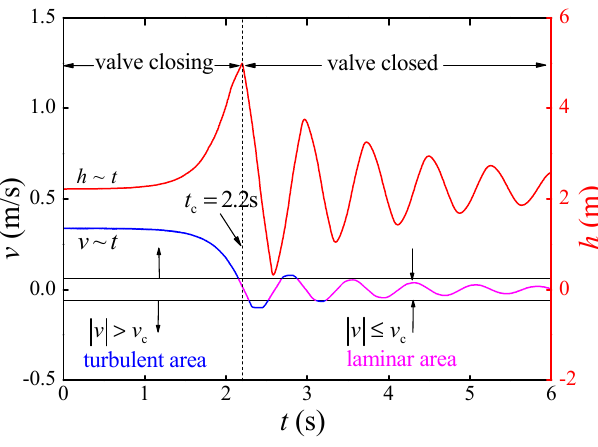
Figure 8. The flow velocity process during hydraulic transient.